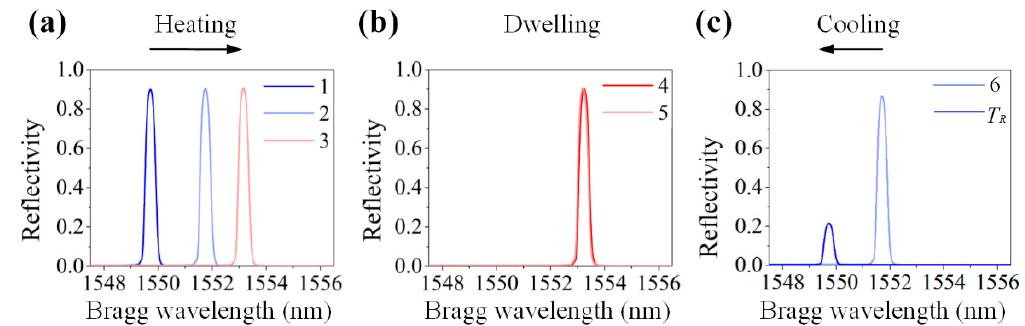
Figure 10. Reflected spectra in ( a ) heating, ( b ) dwelling, and ( c ) cooling phases.